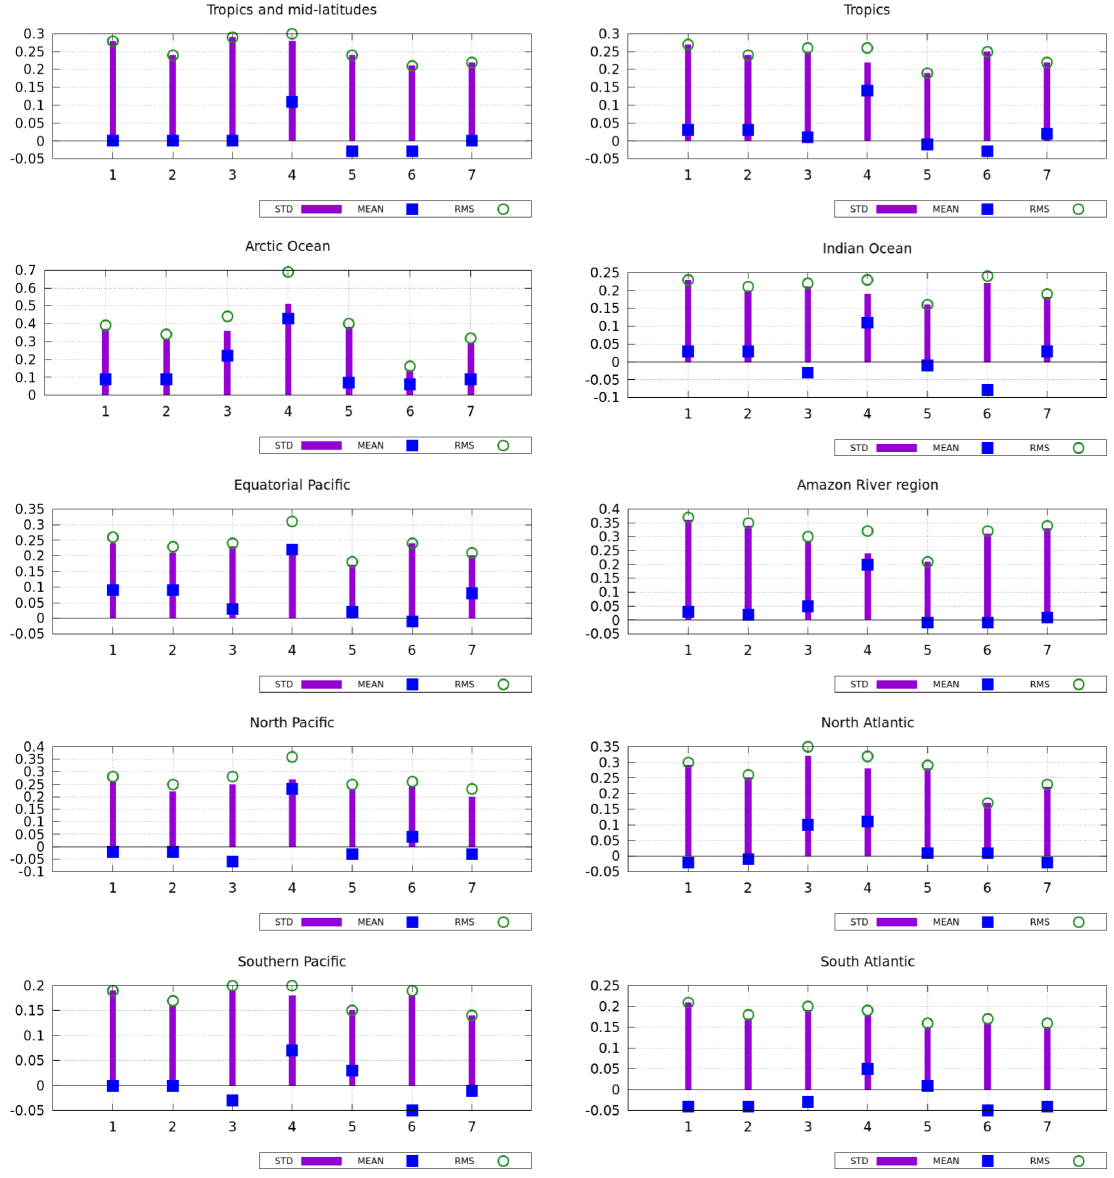
Figure 9. Regional statistics of the comparison with respect to Argo salinity. The numbers in the label plots correspond to the different products that are compared with Argo SSS: 1-BEC HR, 2-BEC LR, 3-CATDS, 4-JPL, 5-REMSS, 6-CMEMS, and 7-BEC